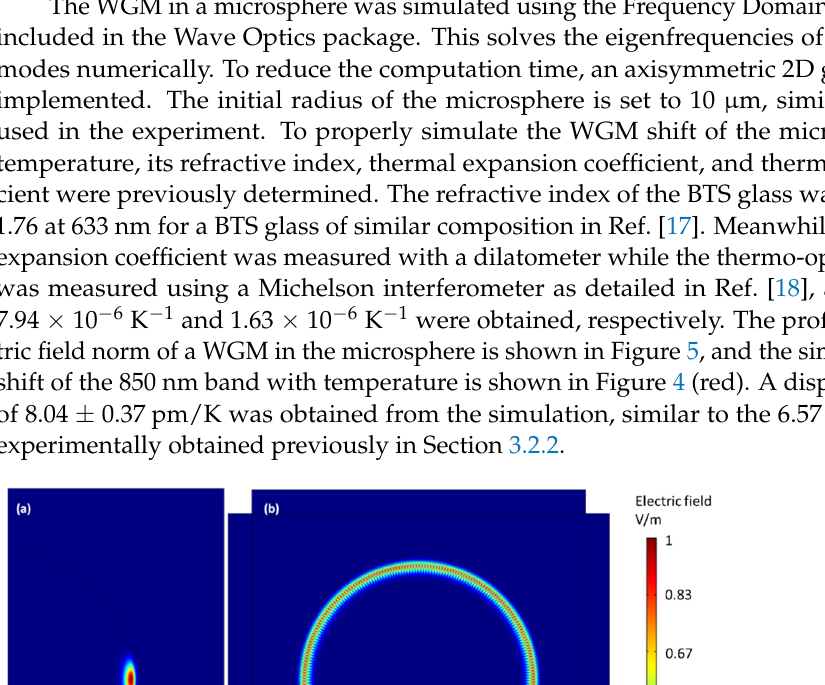
Figure 4. Displacement of the WGM peaks (at 850 nm) as a function of temperature, obtained from experimental data (blue) and simulations (red). The error bars represent the standard error of 20.4 pm.